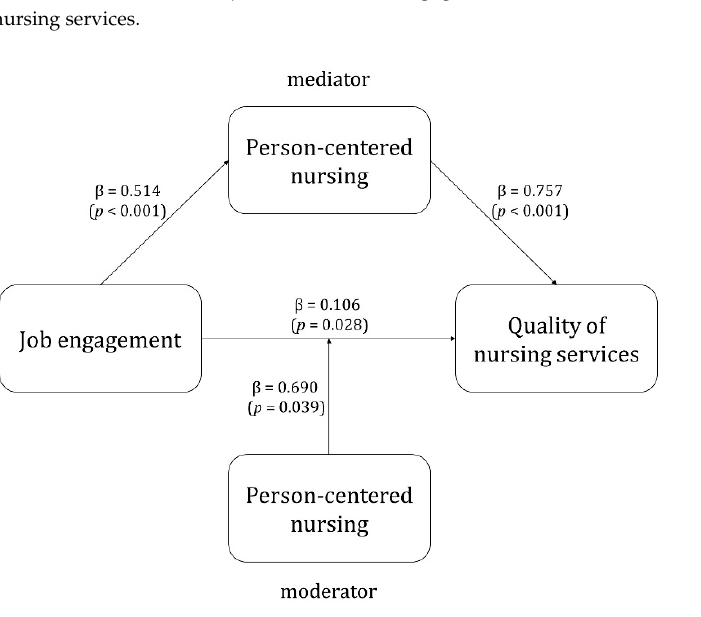
Figure 1. Mediating effects and moderating effects of person-centered nursing between job en- gagement and quality of nursing services. Table 4. Mediating effects of person-centered nursing on the relationship between job engagement and quality of nursing services ( N =